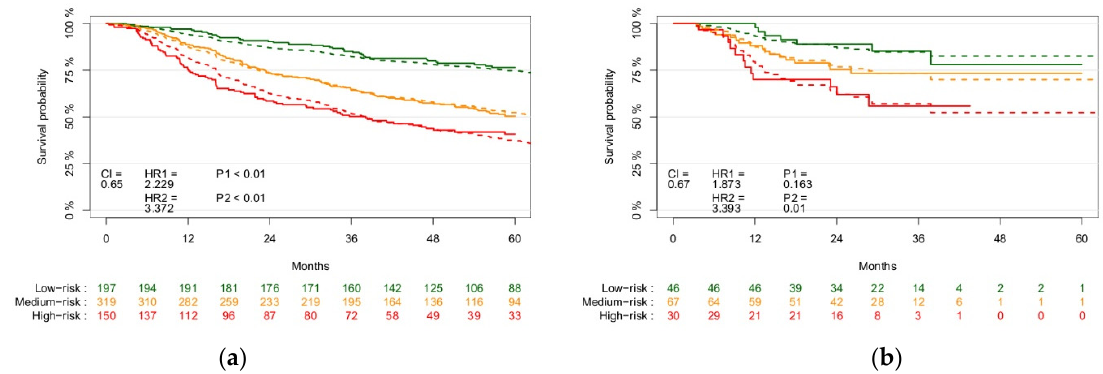
Figure 3. Kaplan–Meier survival curves of the training ( a ), n = 666) validation (( b ), n = 143) patient cohorts stratified into low-, medium-, and high-risk groups, showing log-rank test p -value of the split between risk groups and the CI of the radiomics features-based model performance. The solid lines represent the observed survival curves, and the dashed line the corresponding predicted survival curves.